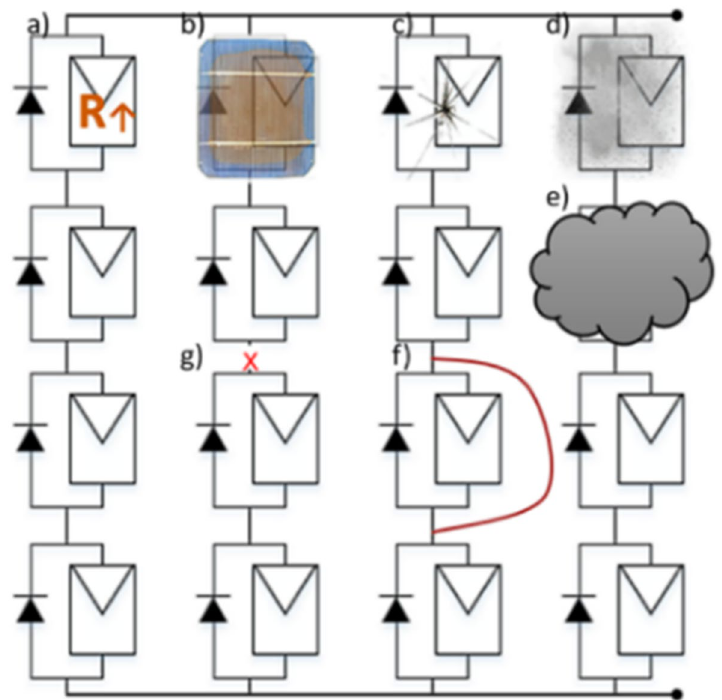
Fig. 1 Manifestation of common types of faults on the DC side of a PVS. a Degradation of the